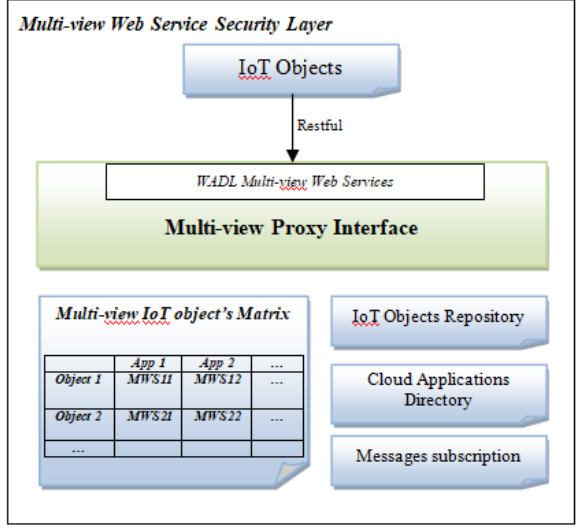
Fig. 1. Architecture schema of the Multi-view Web service security